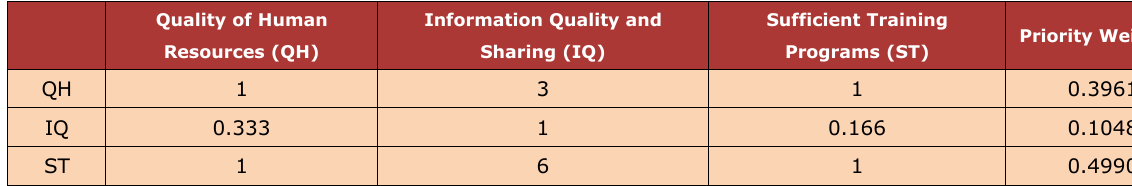
Table 5.4. Strategies of Employee perspective